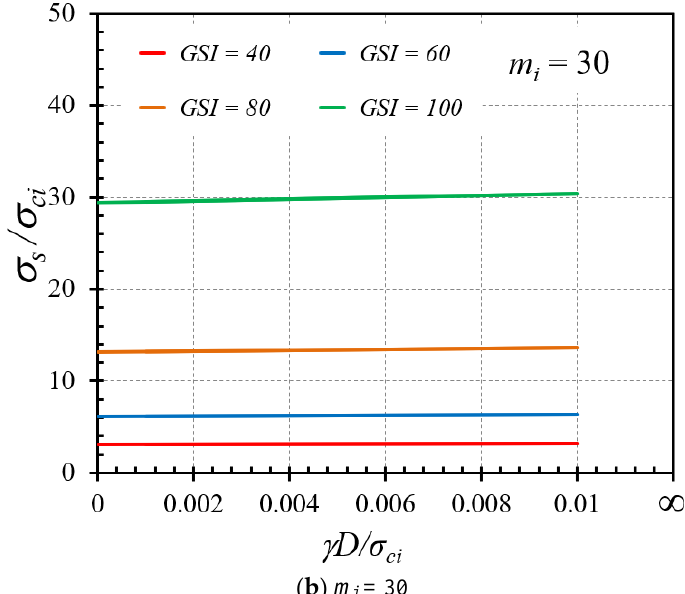
Figure 14. Impact of γ D/ σ ci on the stability solutions of tunnel headings ( C/D = 5 and P/D = 2).